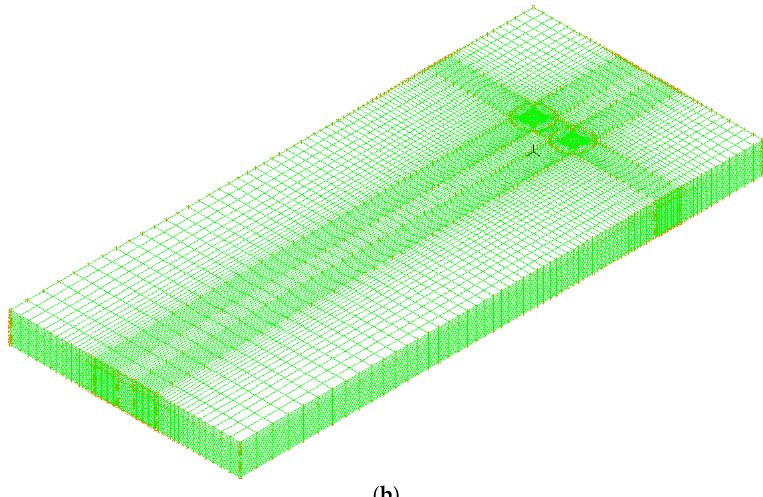
Figure 5. Wind field calculation model. ( a ) Single tank. ( b ) Double tank.